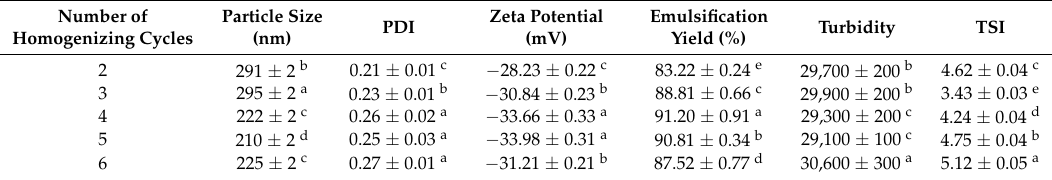
Table 4. Effect of number of homogenizing cycles on emulsion stability of